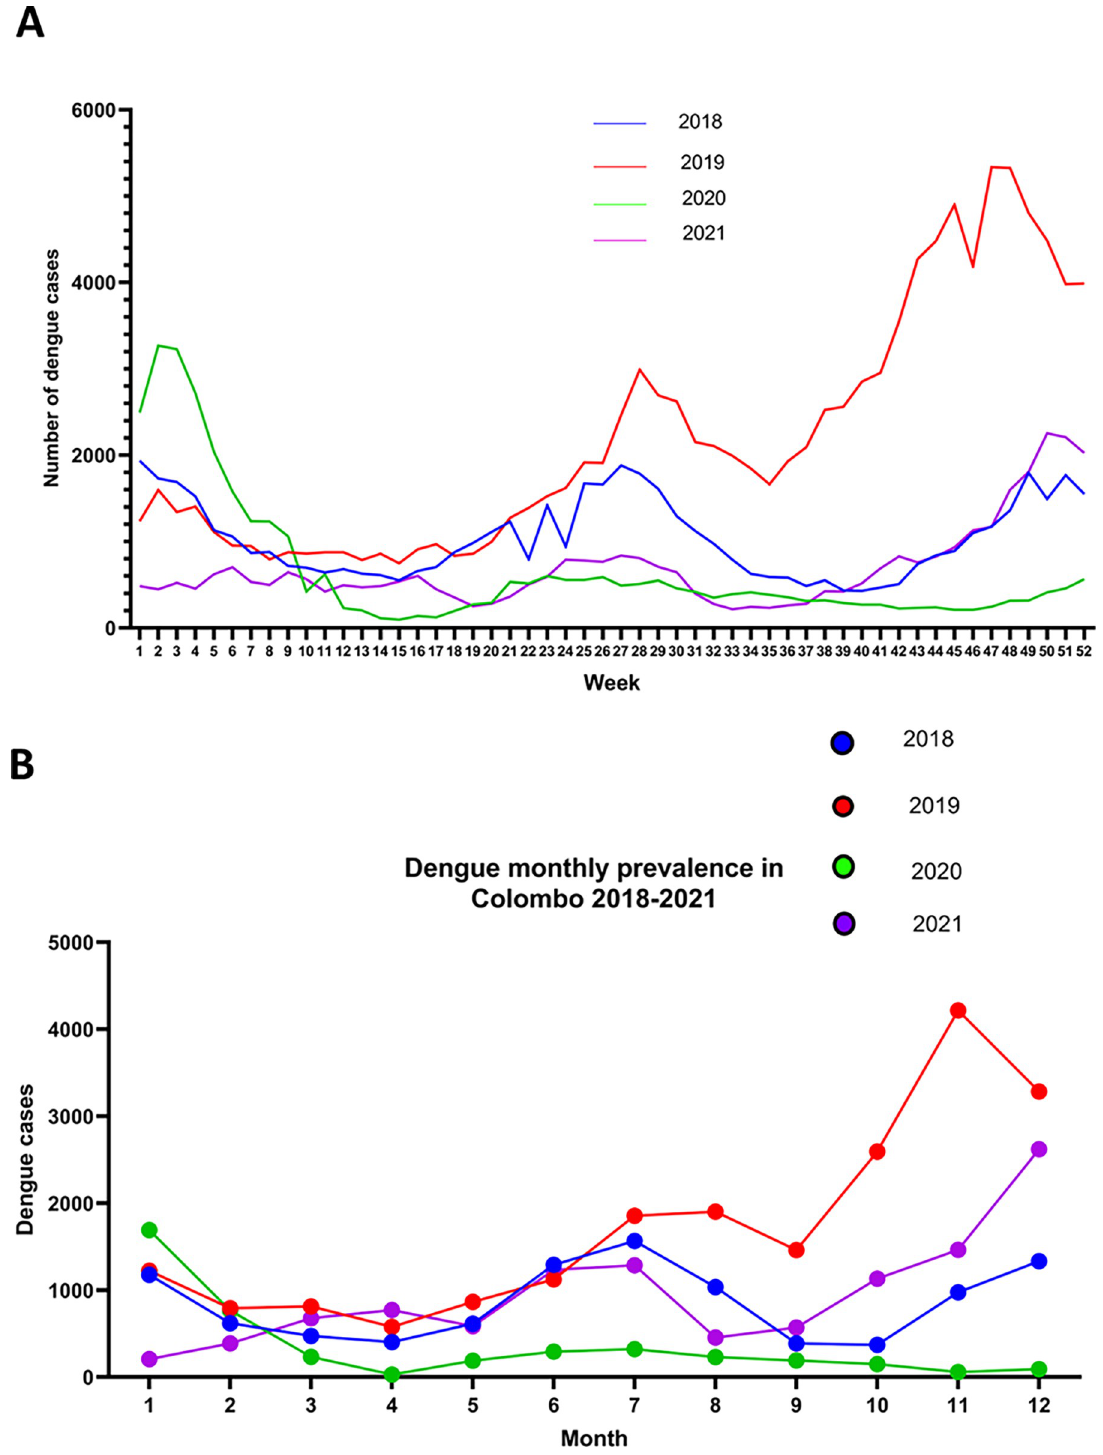
Fig 1. The number of dengue cases reported from 2018 to 2021. The weekly reported number of dengue cases for Sri Lanka from 2018 and 2019 (A) and the weekly number of dengue cases reported in the Colombo district (B), was obtained from the National Dengue Control Unit (NDCU) active dengue surveillance platform DenSys, which collects data from sentinel hospitals and epidemiological surveillance.